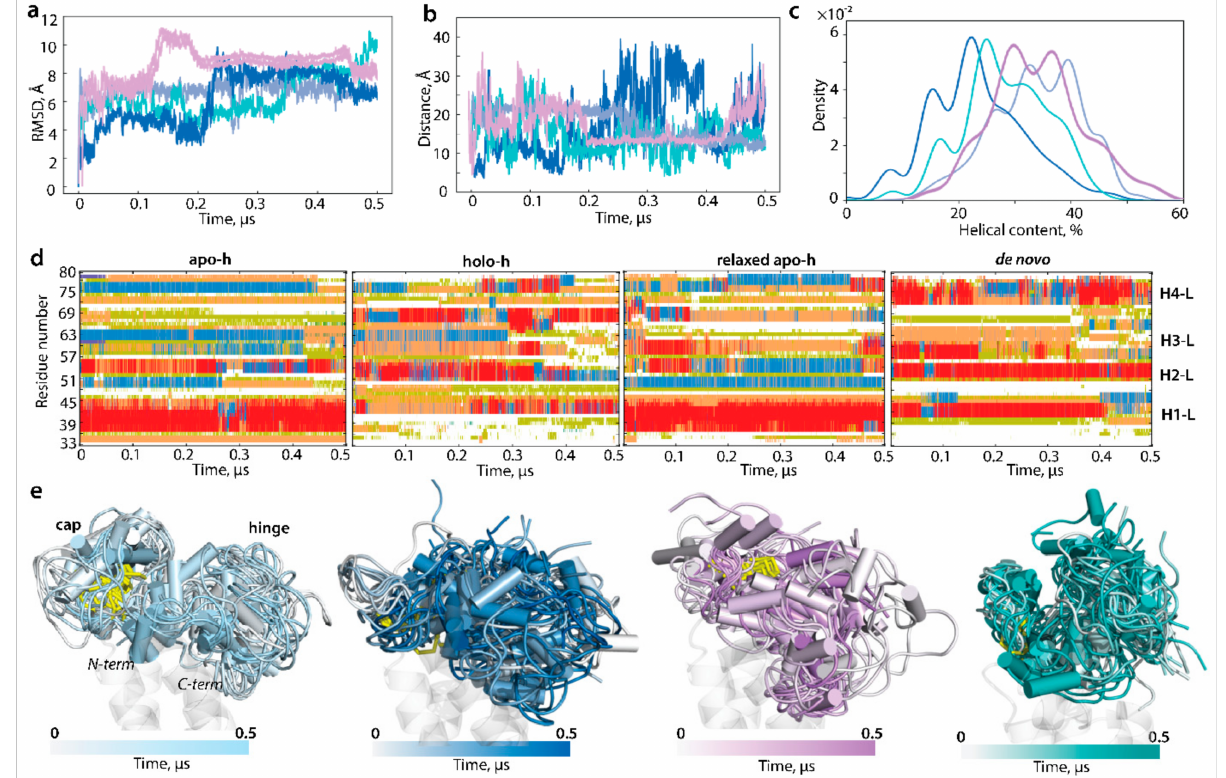
Figure 7. Structure of cleaved L-loop studied as fully released polypeptide. ( a ) RMSDs of each form after C α -atoms fitting to their respective initial conformation. ( b ) Distance between L-loop ends (C α − C α atoms). ( c ) Overall helical content (left), the content of α - (middle), and 3 10 -helices (right) observed in cMD conformations of each form. ( d ) Time-dependent evolution of each L- loop form secondary structures (from left to right) apo-h, holo-h, relaxed apo, and de novo, as assigned by DSSP: α -helix is in red, 3 10 -helix is in blue, turn is in orange, and bend is in dark yellow. ( e ) Superimposition of 20 conformations taken each 25 ns of cMD simulations of L-loop relaxed apo-h and holo-h forms. The colour gradient shows the evolution of the trajectory, from light (t = 0) to dark (t = 5 µ s). Protein is shown as cartoon and disulfide bridges as yellow sticks. The studied entities of L-loop are distinguished by colour: apo-h is in light blue, holo-h is in dark blue, relaxed apo-h is in lilac, and de novo model is in